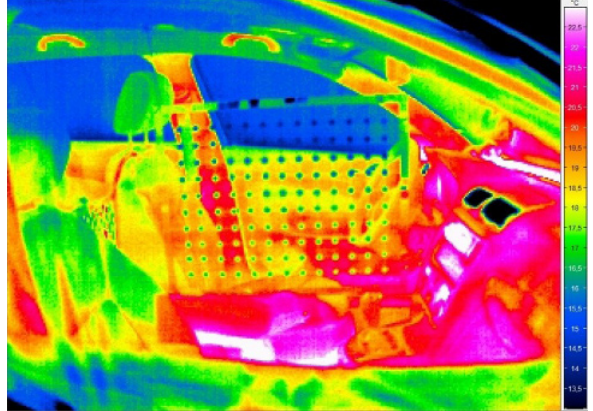
Fig. 13. The original thermogram of the cold air stream measuring between the front passenger and driver area by measuring from the tripod stand